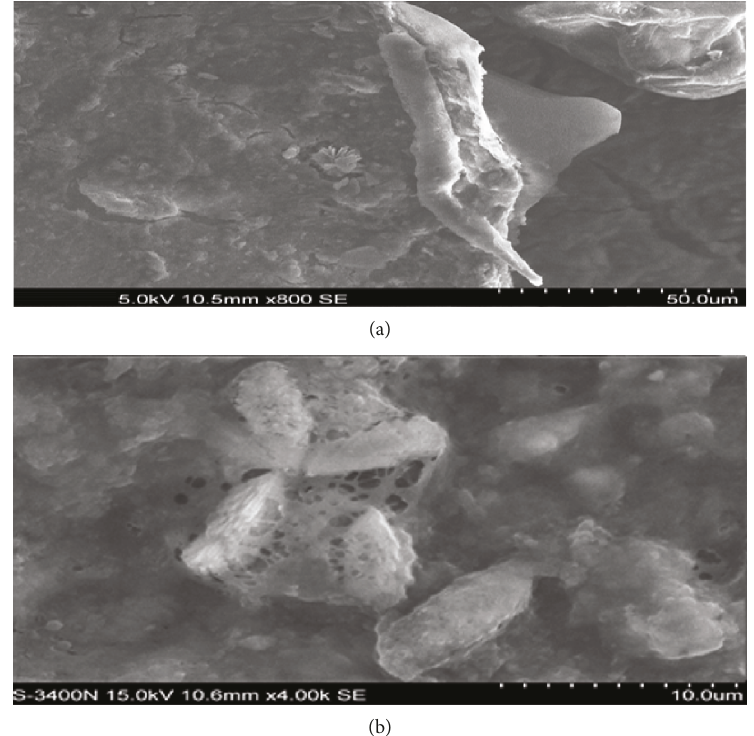
Figure 6: SEM images of membrane fouling. (a) The microorganisms on cake layer; (b) the EPS on gel layer.